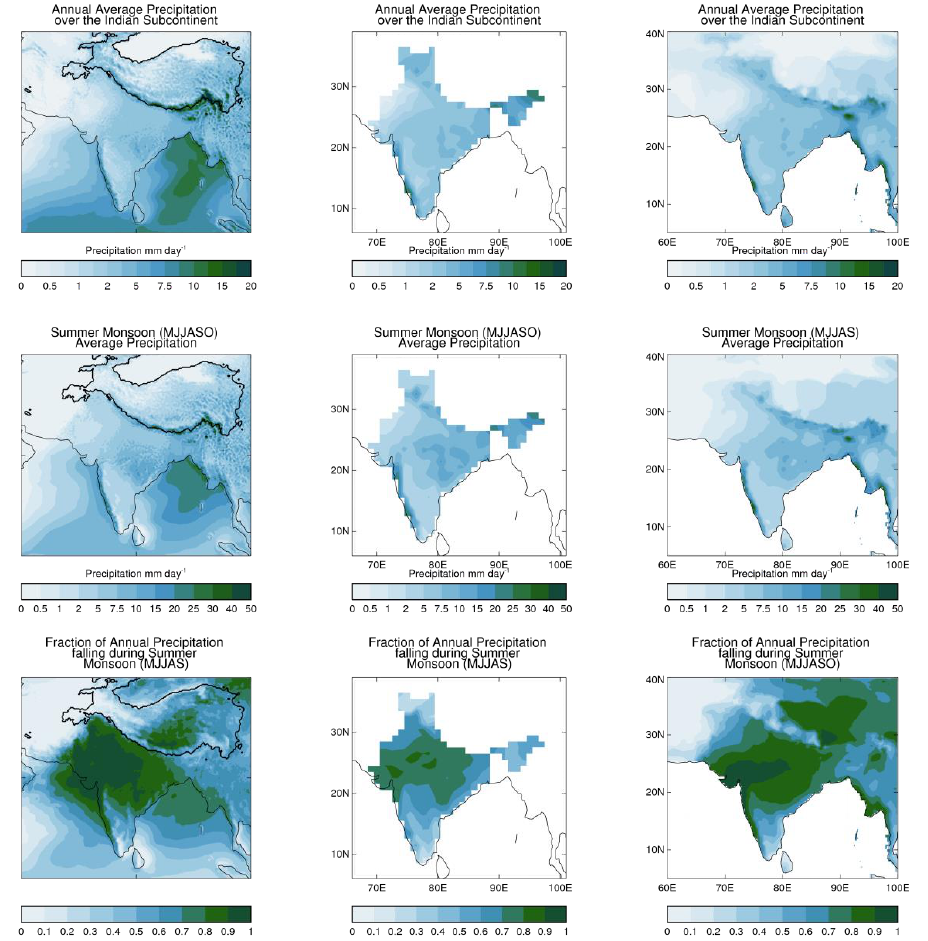
Figure 2. Precipitation over the Indian Subcontinent (1992–2007) as simulated by downscaling ERA-Interim reanalysis using the HadRM3 regional climate model compared against observation data from the Indian Meteorological department (Rajeevan et al., 2008) and Aphrodite (Yatagai and Yasunari, 1994). The 2500ma.s.l. contour is shown on the left-hand plots. Note that the RCM data are on a rotated pole projection.